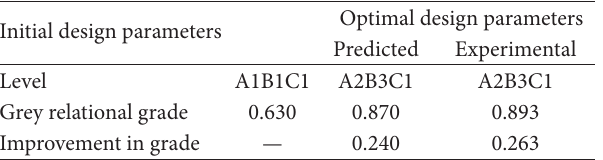
T 10: Results of the con�rmation experiment.